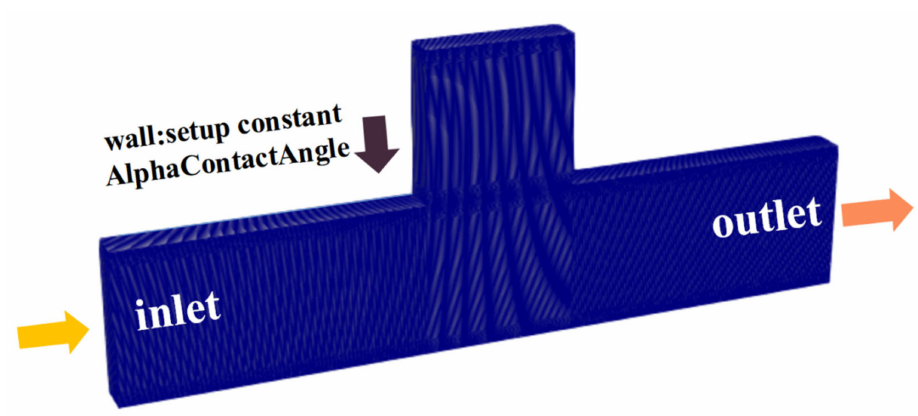
Figure 2. Numerical mesh model of the dead‑end